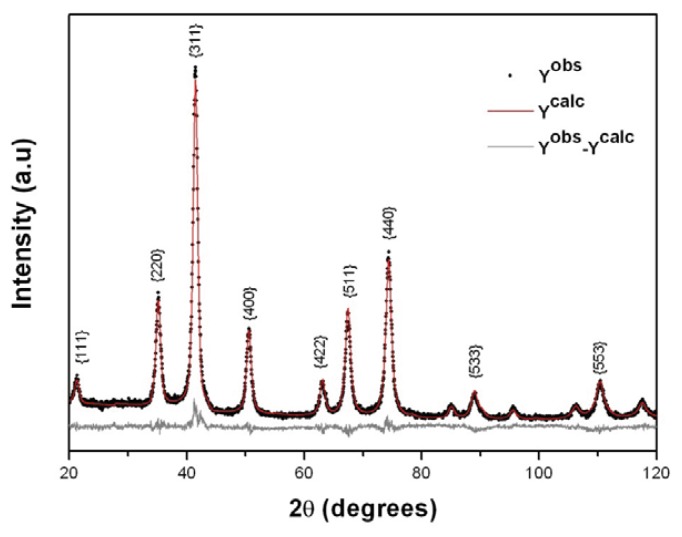
X ray powder diffraction pattern of Fe3O4.